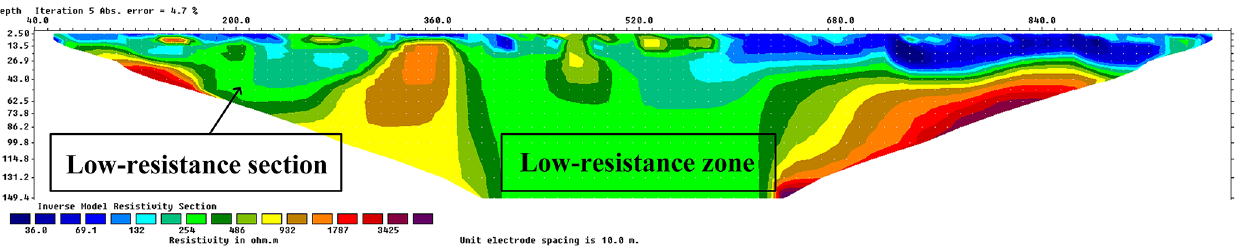
Figure 15. Profile view of survey line L1 obtained using the high-density electrical method.